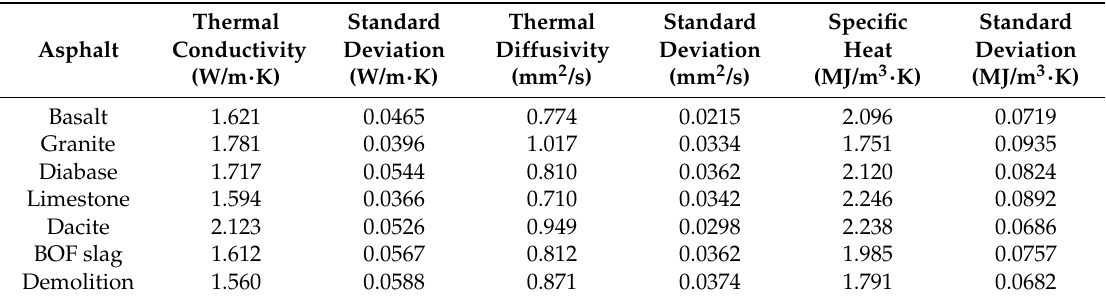
Table 5. Thermal properties of different asphalt concrete.